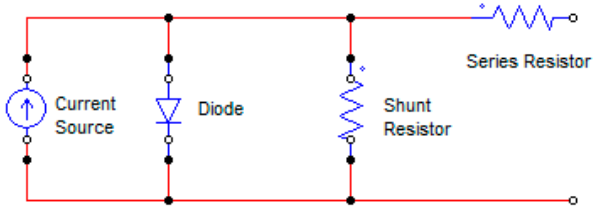
Figure 9. Equivalent circuit for a solar cell.